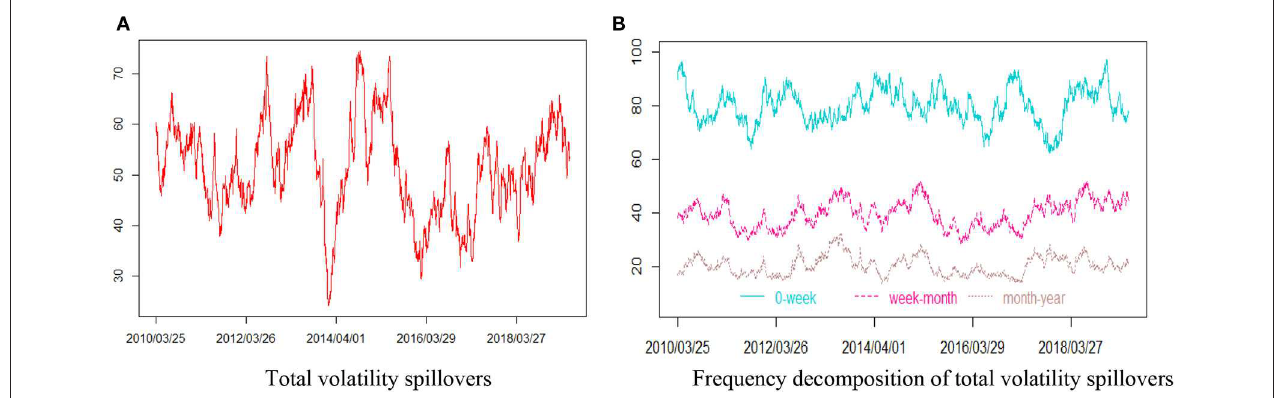
FIGURE 4 | Total volatility spillovers of West Texas intermediate (WTI) futures and China’s bulk commodity sectors. (A) The total volatility spillovers measured by Diebold and Yilmaz (2012), lag 2, window size 200. (B) The frequency decomposition measured by Baruník and Krehlík (2018), lag = = Short-term: frequencies from 1 to 5 days period (0-week, dark turquoise). Medium-term: frequencies from 5 to 20 days period (week-month, deep pink). Long-term: frequencies from 20 days to 200 days period (month-year, rosy